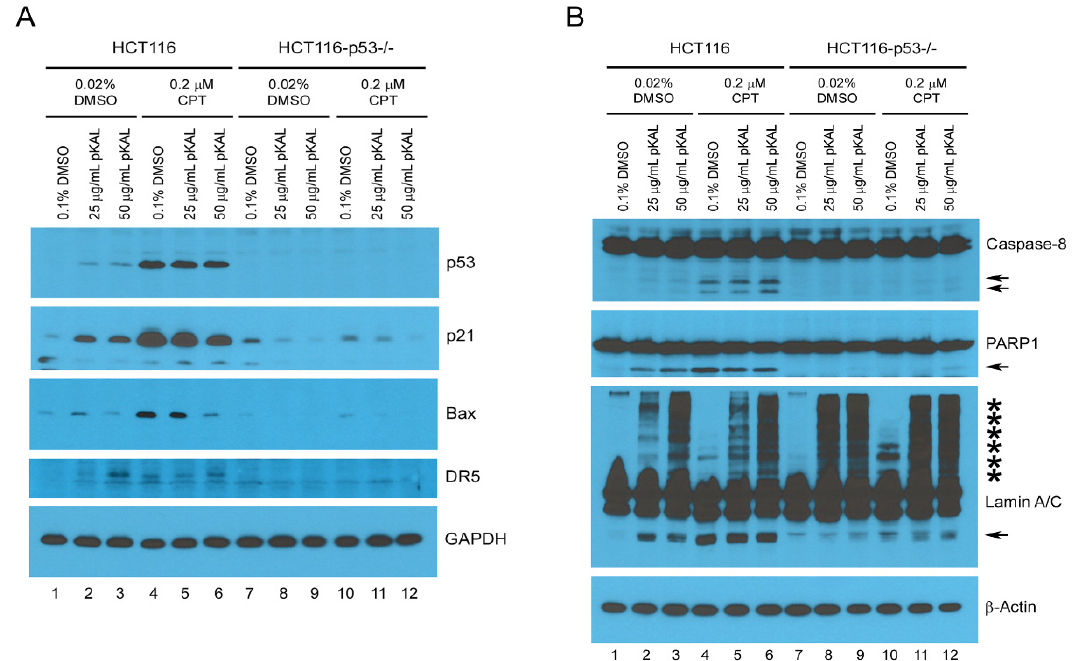
Figure 7. Comparison of cell death mechanisms by pKAL and CPT between p53-wild and p53-null HCT116 cells. ( A , B ) HCT116 and HCT116-p53 − / − cells were split on a 10 cm culture dish the day before, and then treated with the indicated amounts of drugs for 40 h. The cells were analyzed by Western blot using the indicated antibodies; the arrows indicate the lower molecular weight cleaved form(s) of the corresponding protein, and the asterisks indicate the higher molecular weight post-translational modified forms of lamin A / C ( B ).